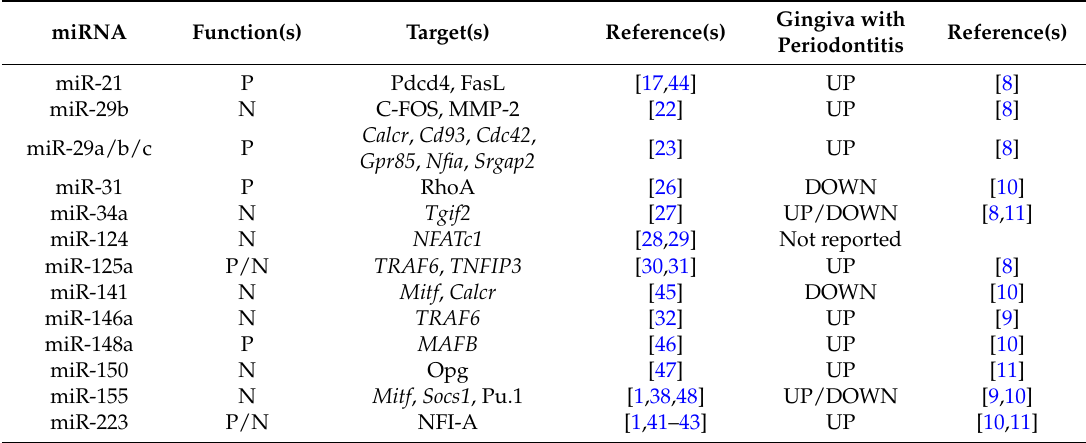
Table 1. Important miRNAs in periodontal disease-related